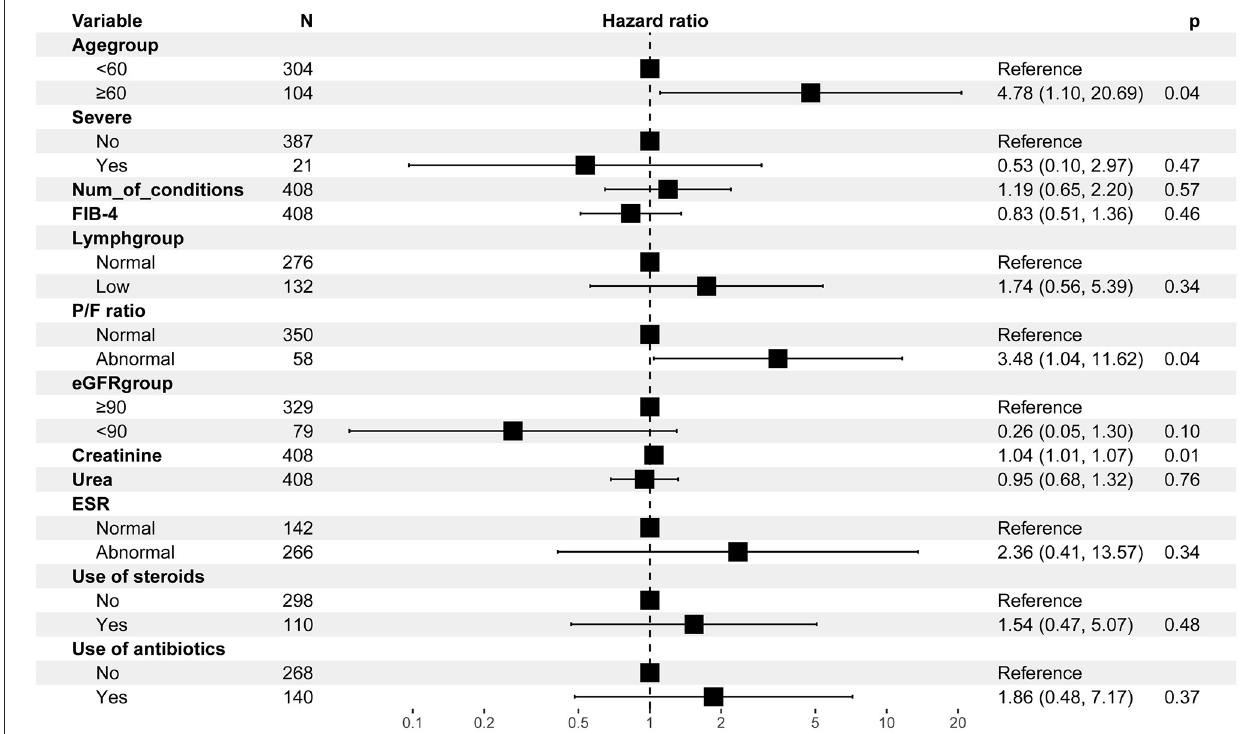
FIGURE 1 | Multivariable Cox regression analysis for the risk of AKI-related events. AKI, acute kidney injury; FIB-4, fibrosis-4; ESR, erythrocyte sedimentation rate; P/F ratio, PaO 2 /FiO 2 ratio. 43 observations were not included in the multivariable analysis due to missing data.